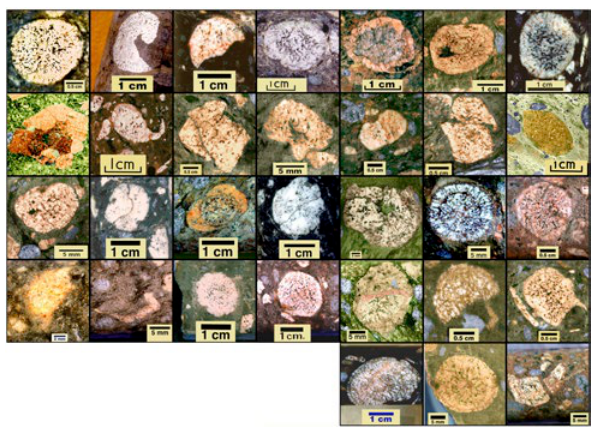
Figure 62. Recording clear observations resolved the problem of composite, plastically deformed, rimmed, “spongy”, bent, broken, joined together again, rounded and apparent shrinkage crack pat- terns in the feldspars of the Tennant Creek porphyroids. Why do these feldspars have features so very different from their normal angular crystal habit? Why do they contain internal crack pat- terns? Logical deductions from hundreds of observations has pro- vided answers and defined the origin of these rocks and the min- eral deposits associated with them. These feldspars have crystallised from ordered but impure accretions of clay that formed when the sediments were